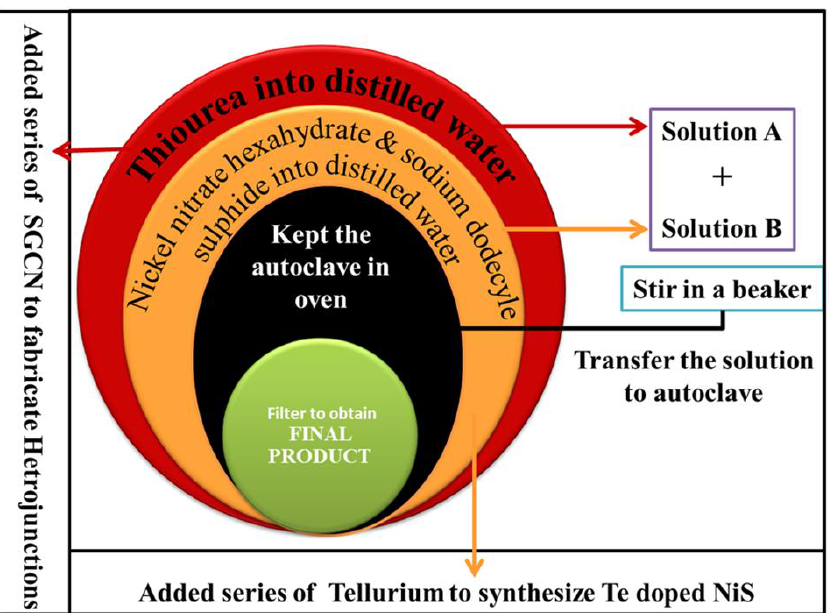
Figure 1. Schematic diagram for the synthesis of nanoparticles.